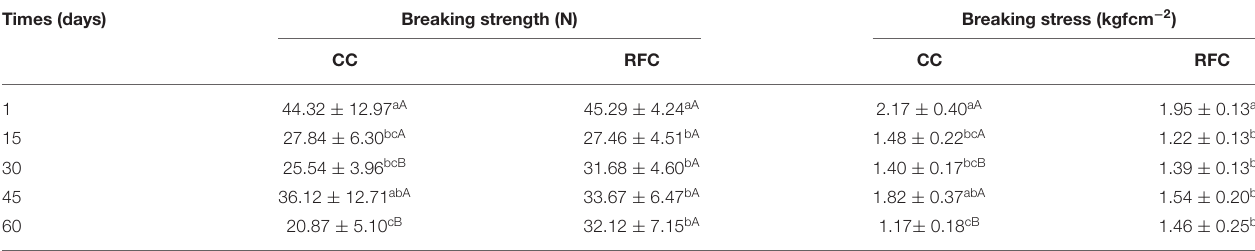
TABLE 4 | Breaking stress (kgf cm-2) and breaking strength (N) of control chocolate bars (CC) and reduced fat chocolate (RFC). Times (days)